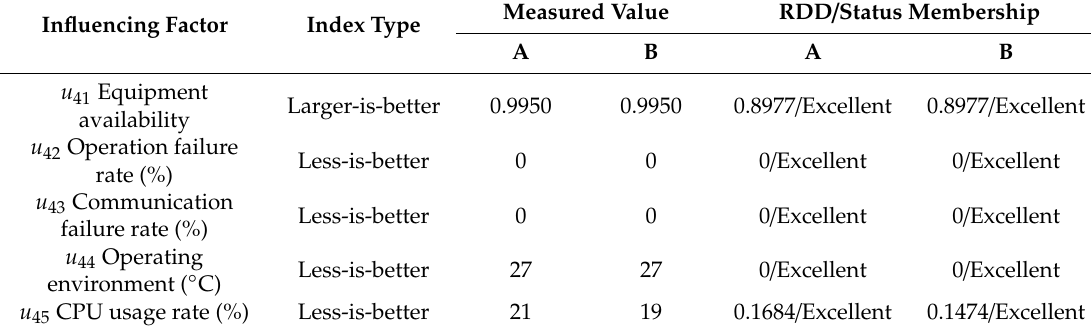
Table 7. Intelligent electronic device (IED) status data and status